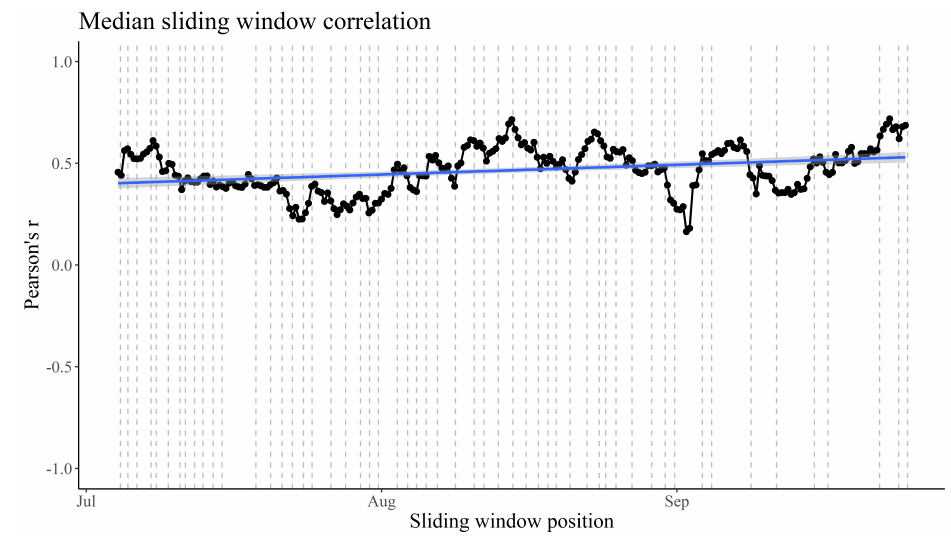
Figure A20. Median sliding window correlation of the number of 8 hourly warnings between individuals over time with a window of 18 periods. The blue line is the result of linear regression (Pearson’s r = − 0.4 + 5.13 · 10 − 4 · (8 h period)). Vertical dotted grey lines show the start time of each version of the virtual